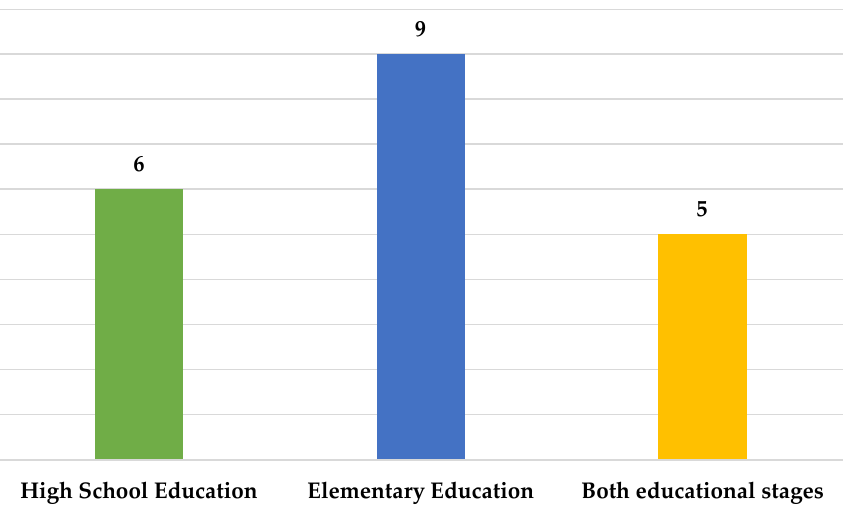
Figure 3. Distribution of the population where the selected studies are being carried out. Table 2. Origin of the studies in the